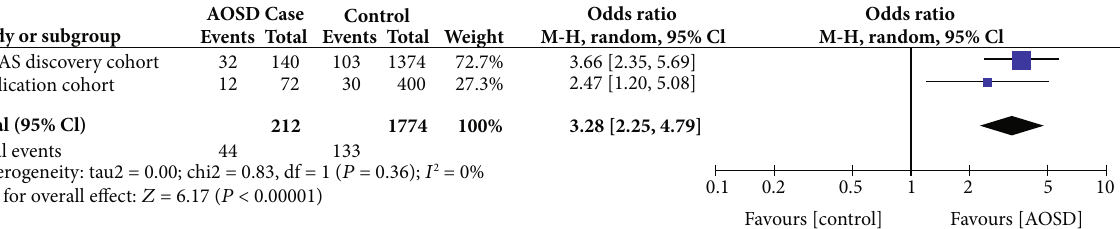
Figure 2: Meta-analysis of the genetic association between rs11102024 and adult-onset Still ’ s disease (AOSD). M-H: Mantel-Haenszel